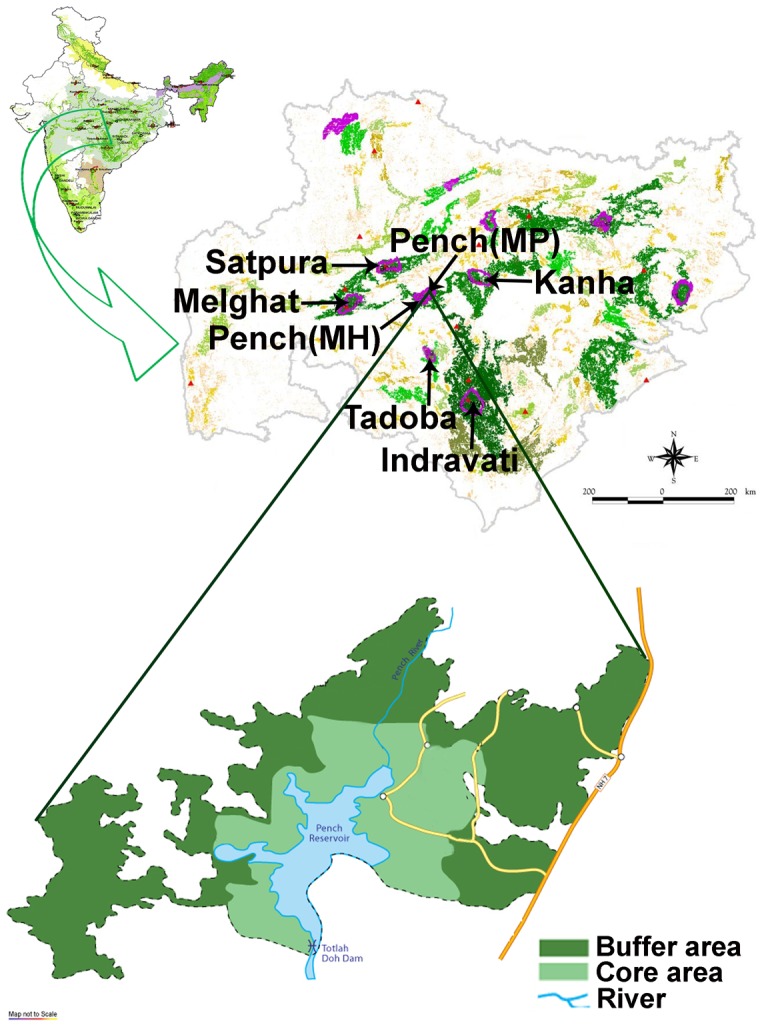
Map showing the location of Pench Tiger Reserve (PTR), Madhya Pradesh, India.